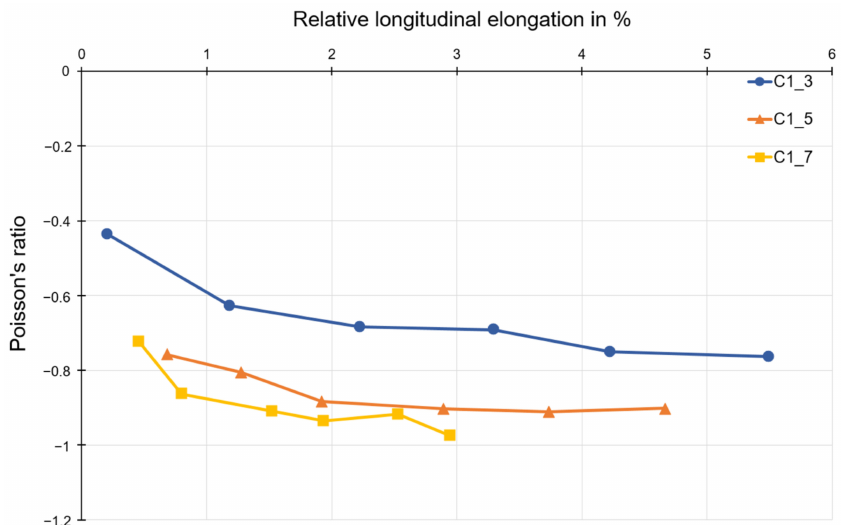
Figure 14. Poisson’s ratio as a function of longitudinal strain for test specimens made of polymer C1. To evaluate the material influence, the results of all materials of a structure consisting of five honeycombs were plotted in a graph as a function of longitudinal strain. This is shown in Figure 15. There is a very good correlation between the curves if the first two measuring points of C1_5 and the first measuring point of C5_5 are neglected. If the structure is subjected to a tensile load, the Poisson’s ratio initially decreases, as already observed for polymer C1, until the minimum of the Poisson’s ratio is reached, at about 4 % relative longitudinal strain. After exceeding the minimum, an almost linear increase follows until the end of the load